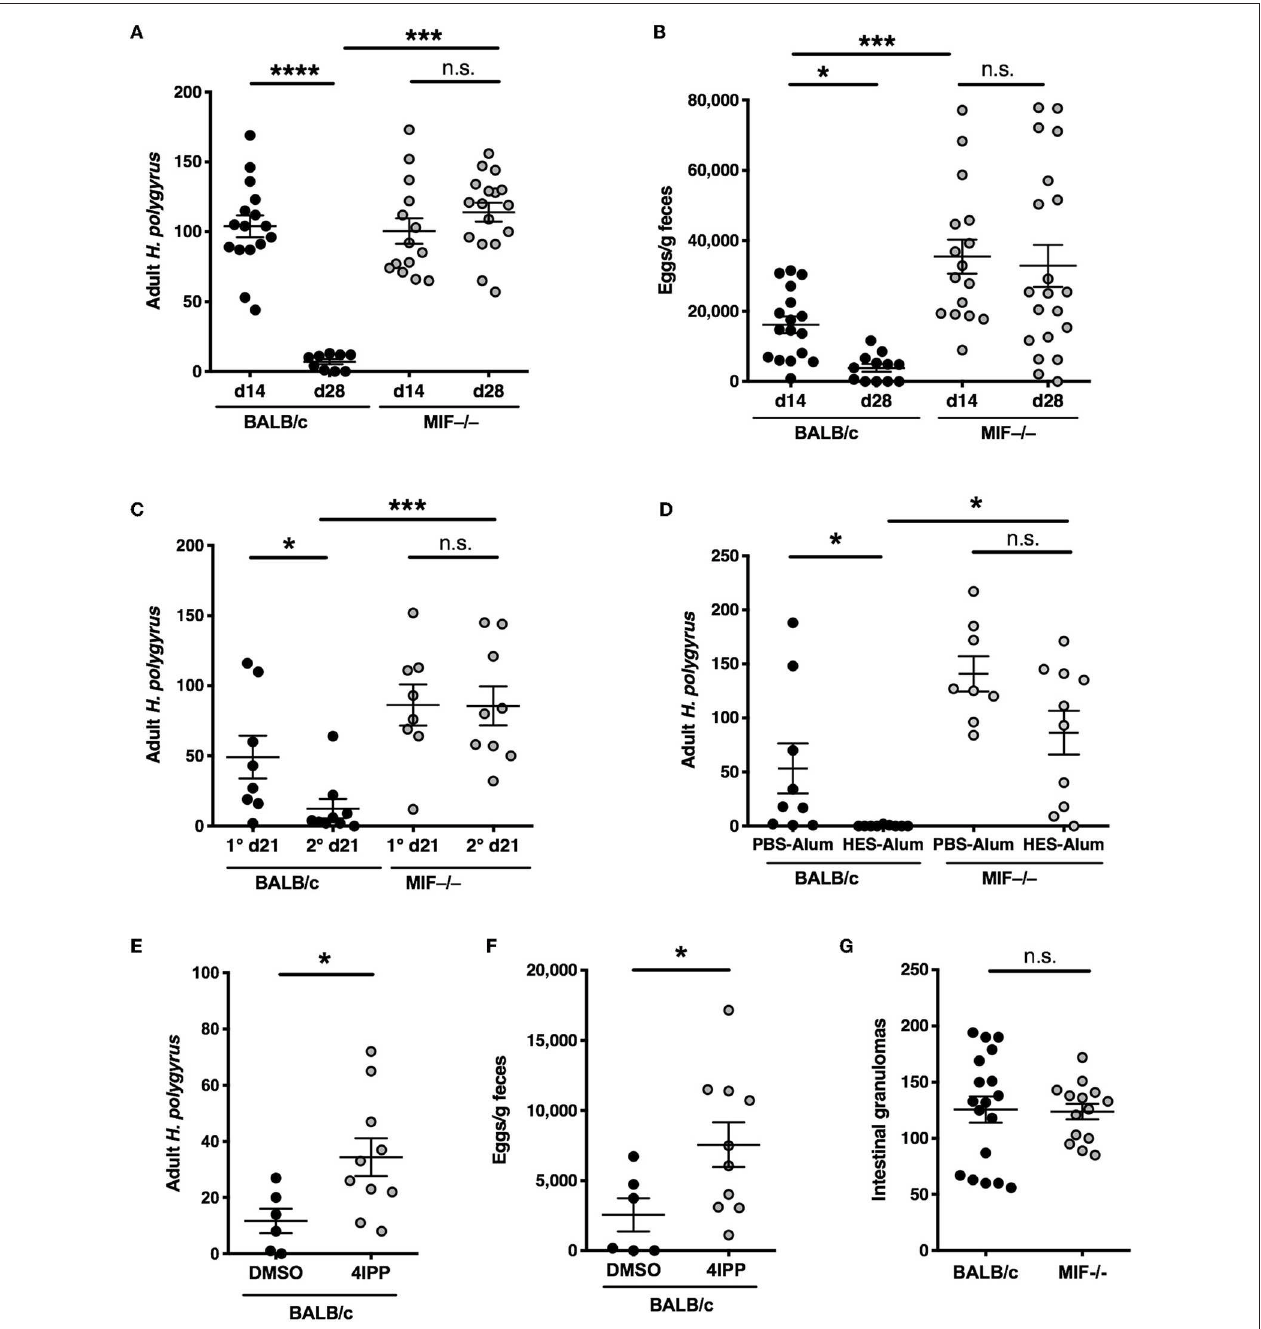
FIGURE 1 | Compromised anti-helminth immunity in the absence of MIF. (A,B) Differential susceptibility of BALB/c and MIF − / − mice to primary infection with H. polygyrus . Adult worm burdens in the small intestine (A) and fecal egg counts (B) were determined at days 14 and 28 post-infection with 200 H. polygyrus larvae by gavage. Data shown are combined from 3 independent experiments. (C) Differential induction of immunity following drug-abbreviated primary infection in BALB/c and MIF − / − mice. At day 28 following infection with H. polygyrus , mice were given 2.5mg of pyrantel embonate by oral gavage, twice over 24h. After a further 14 days, mice were reinfected (or infected for the first time in 1 ◦ groups). Adult worms were enumerated at day 21 post infection. Data shown are combined from 2 independent experiments. (D) Differential expression of vaccine-induced immunity in BALB/c and MIF − / − mice. At day 0, mice were injected with 10 µ g of HES in alum, or PBS-alum control, followed by booster injections of 1 µ g HES or PBS at days 28 and 35. On day 42 all mice were infected with H. polygyrus . Adult worm burdens were counted at day 21 post-infection. Data shown are combined from 2 independent experiments. (E,F) The MIF inhibitor 4-iodo-6-phenylpyrimidine (4-IPP) inhibits immunity in BALB/c mice infected with H. polygyrus . 1mg 4-IPP in DMSO or DMSO alone was injected i.p. at days − 1, 0, 2, 4, and 6 post-infection. Adult worms (F) and egg burdens (G) were enumerated at day 28 post-infection. Data shown are combined from 2 independent experiments. (G) Numbers of intestinal granulomas in BALB/c and MIF − / − mice 14 days following primary infection with H. polygyrus . Data shown are combined from 2 independent experiments. n.s., not significant, * p < 0.05, *** p < 0.001, **** p < 0.0001.